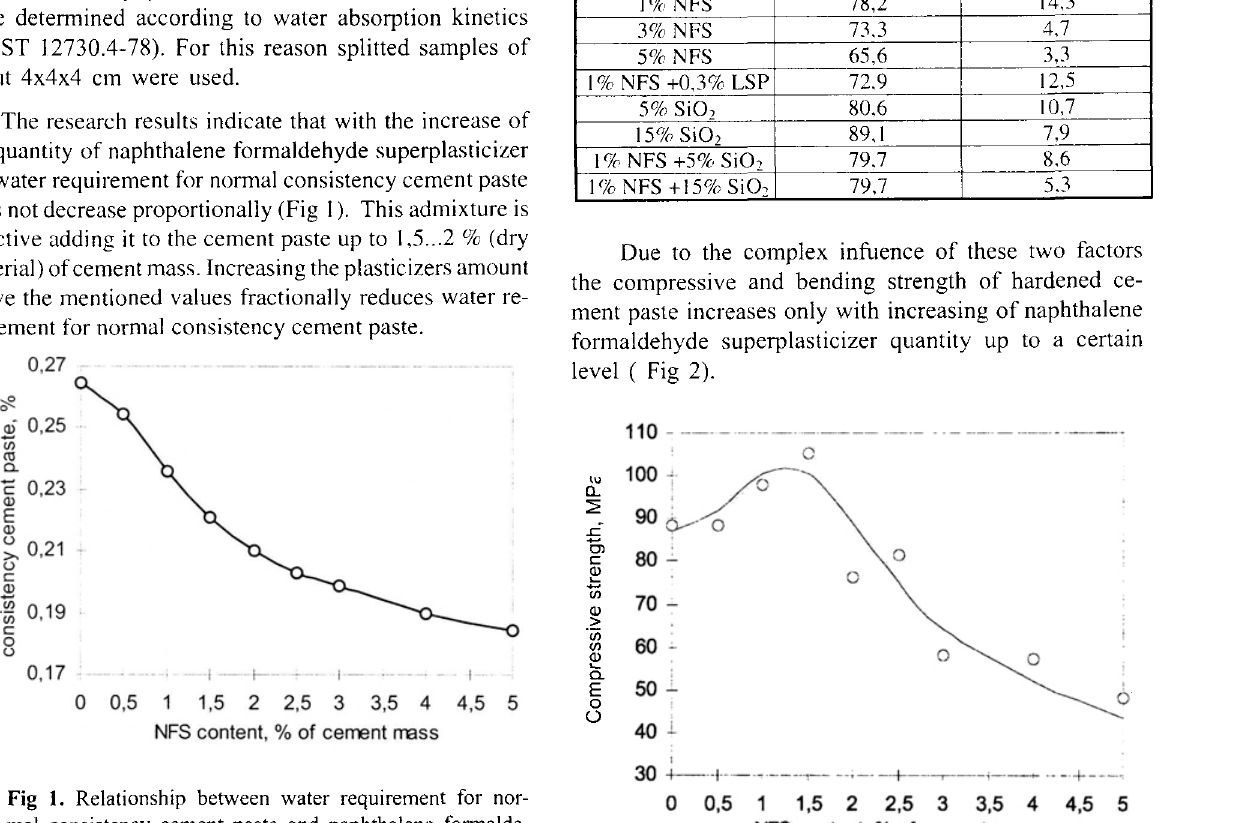
Fig 1. Relationship between water requirement for nor mal consistency cement paste and naphthalene formalde hyde superplasticizer (NFS) content